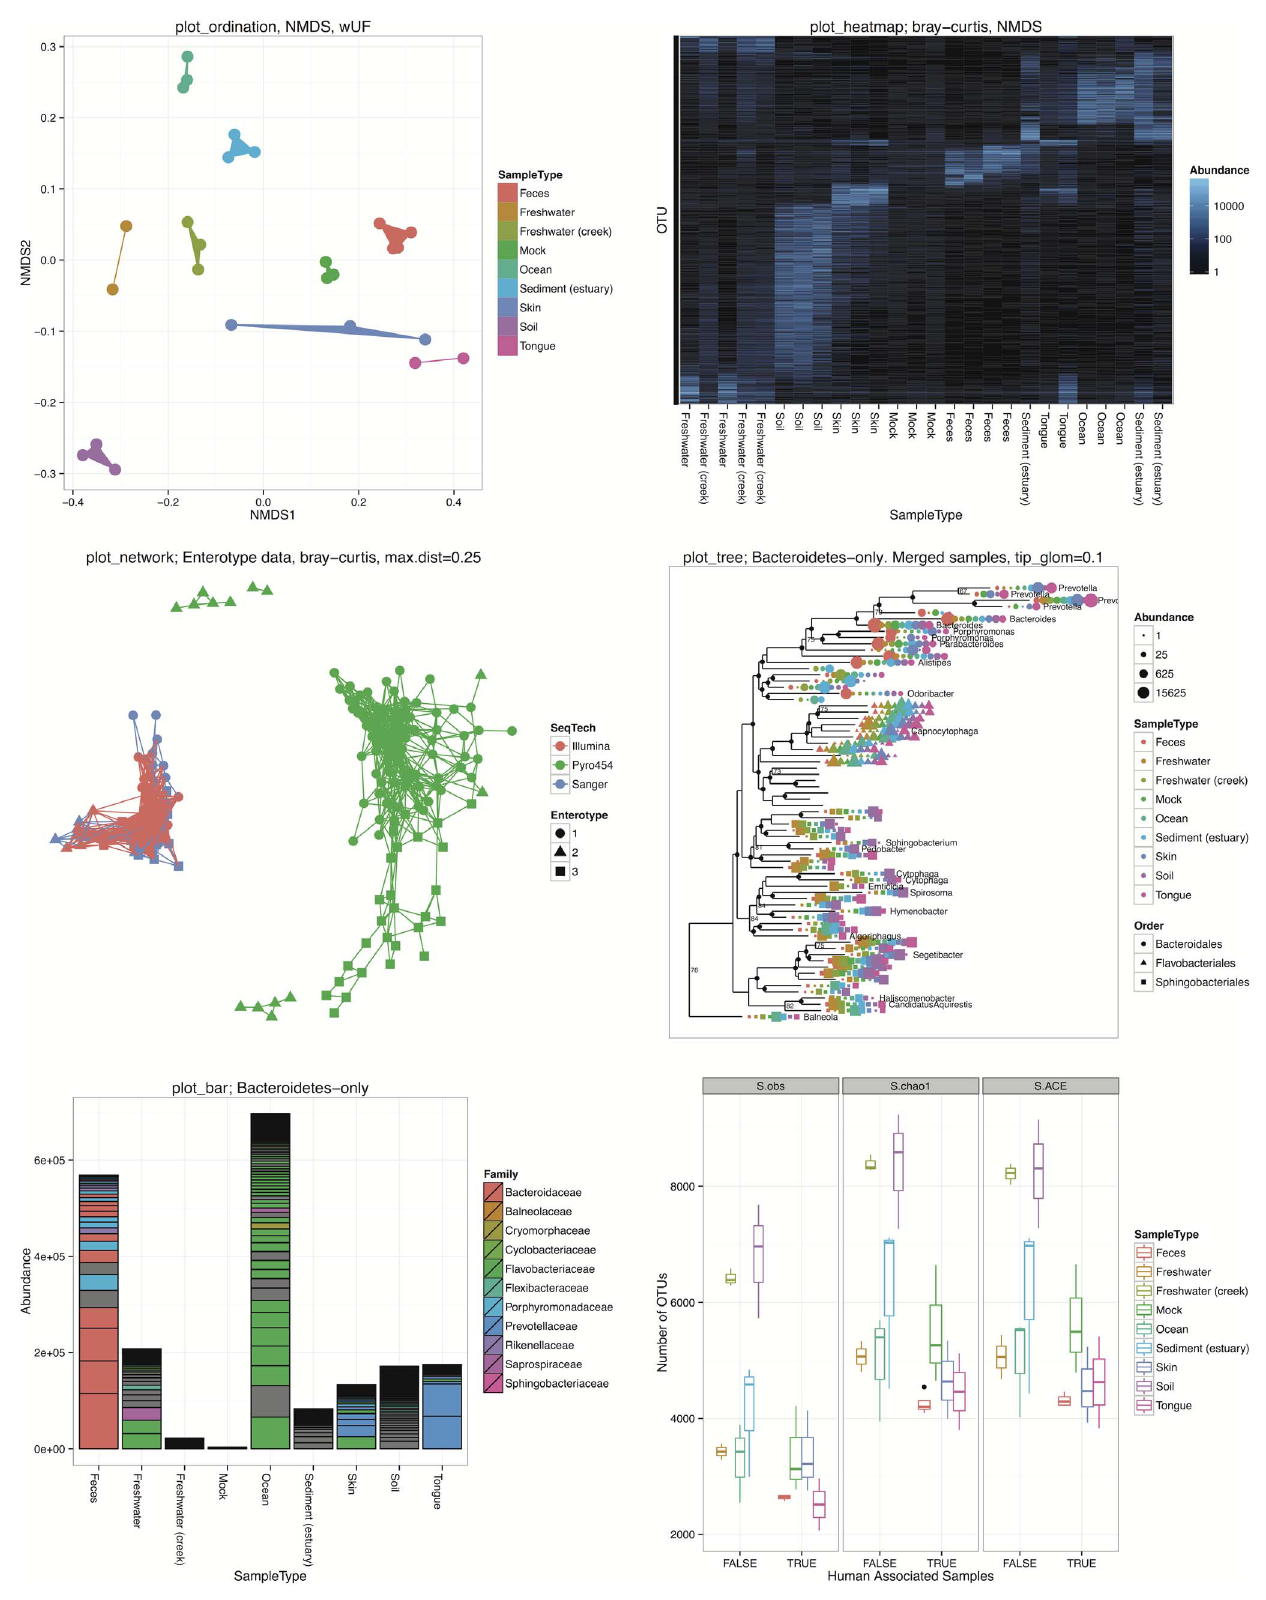
Figure 4. Graphic functions of the phyloseq package. The phyloseq class is an experiment-level data storage class defined by the phyloseq package for representing phylogenetic sequencing data. Most functions in the phyloseq package expect an instance of this class as their primary argument. See the phyloseq manual The Global Patterns [47] and Enterotypes [91] datasets are included with the phyloseq package. The Global